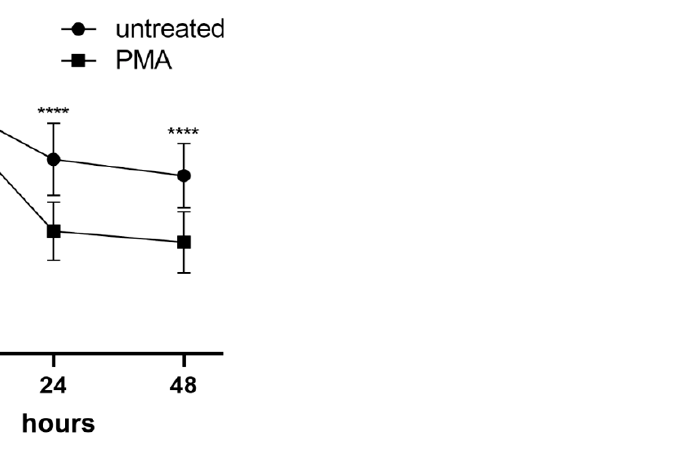
Figure 1. PP1- and PP2A-type phosphatases are inhibited during PMA-induced monocyte differ- entiation. THP-1 cells were treated with none or 100 nM PMA, then cell lysates were prepared at the indicated times, and phosphatase activity was assayed as described in Materials and Methods. Phosphatase activity of untreated cells at the start of incubations was taken as 100%. Statistical analysis was performed by multiple t-test and Sidak’s multiple comparisons ( n = 4, **** p < 0.0001, ns: not significant).